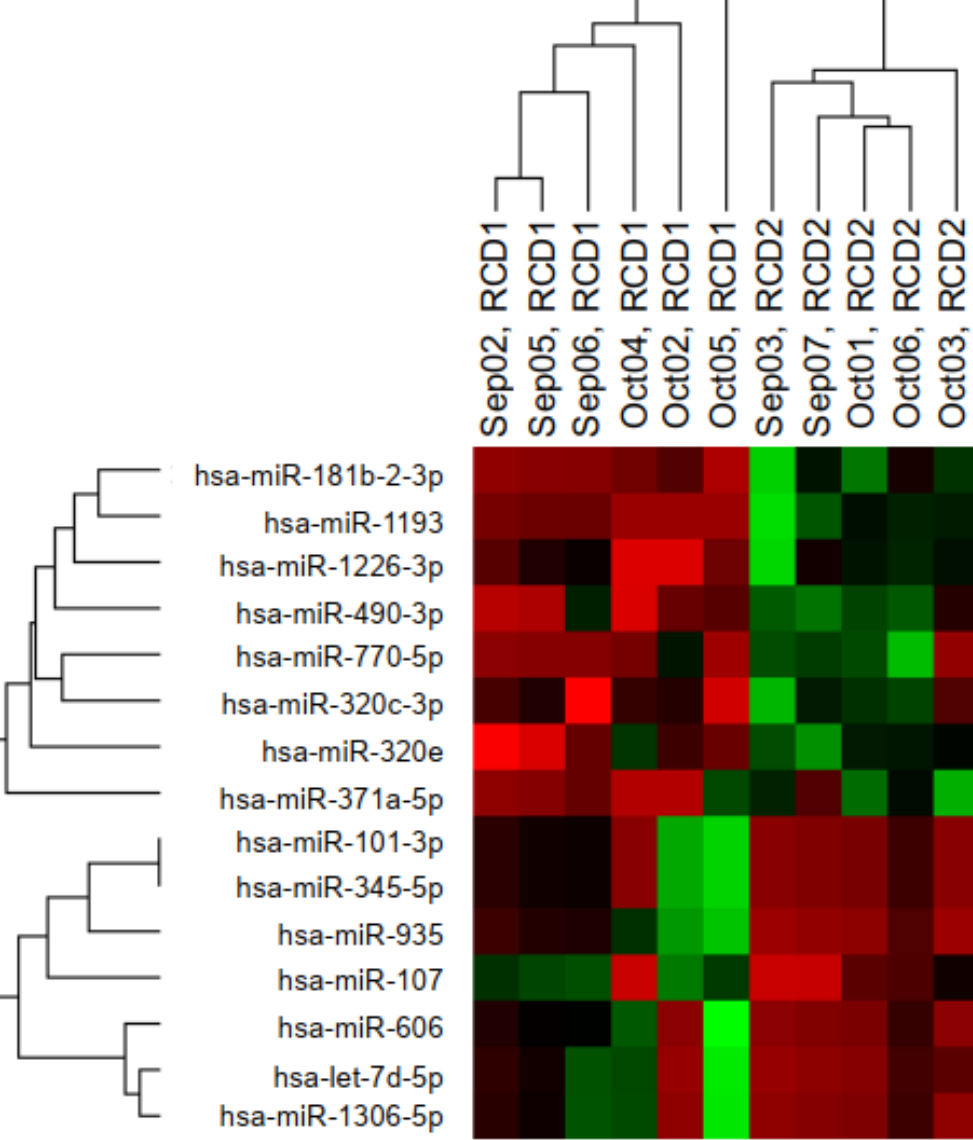
Figure 2. An expression heatmap of the deregulated miRNAs in RCD2 ( n = 5) vs. RCD1 ( n = 6) patients. The upregulated miRNAs are indicated in Red, and the downregulated miRNAs are indicated in Green. p value < 0.05. Table 1. The dysregulated miRNAs evaluated in serum samples obtained from RCD2 and RCD1 patients.